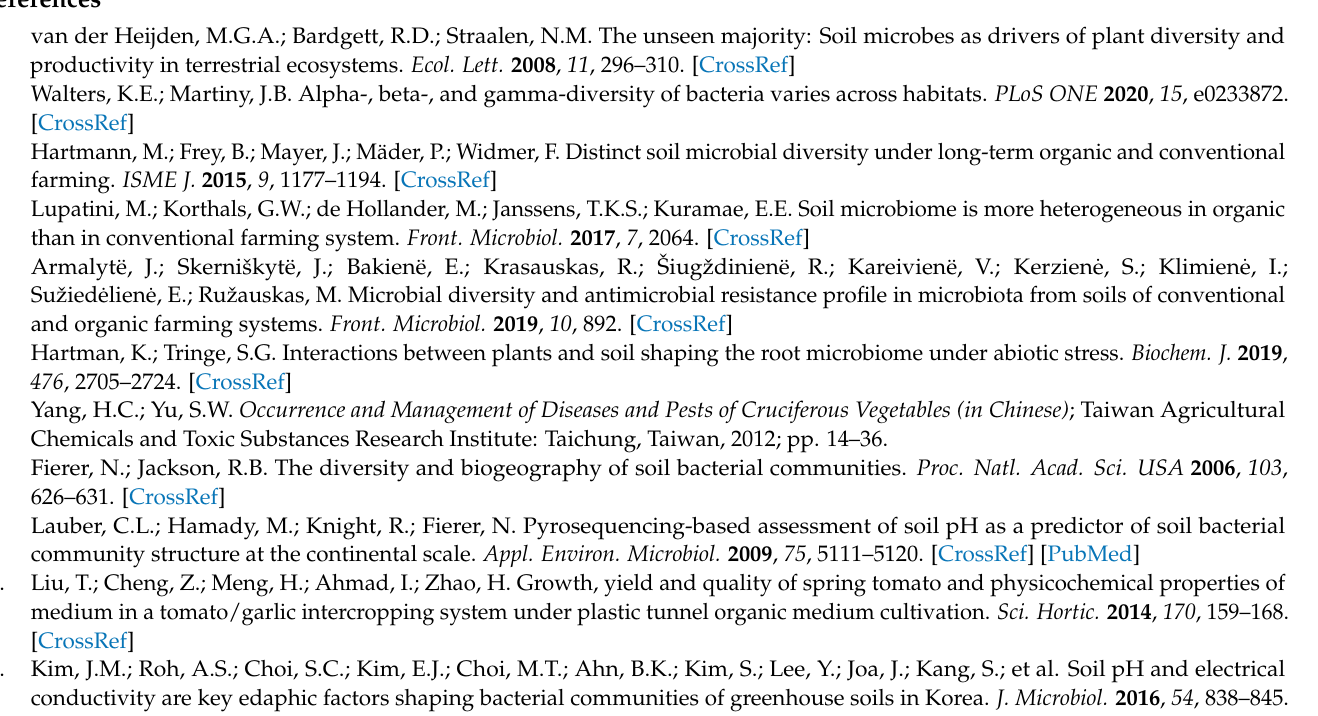
abundance, Table S2: Statistical test on OUT relative abundance, Table S3: Physicochemical properties of rhizosphere soil, Table S4: Beta diversity correlation analysis, Table S5: Statistical analysis of abundance in Bacillus